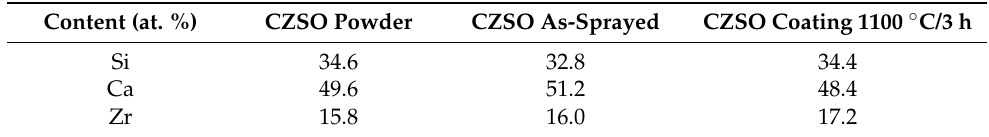
Table 3. XRF results of the powder and coating before and after thermal aging. Content (at. %) CZSO Powder Content (at.